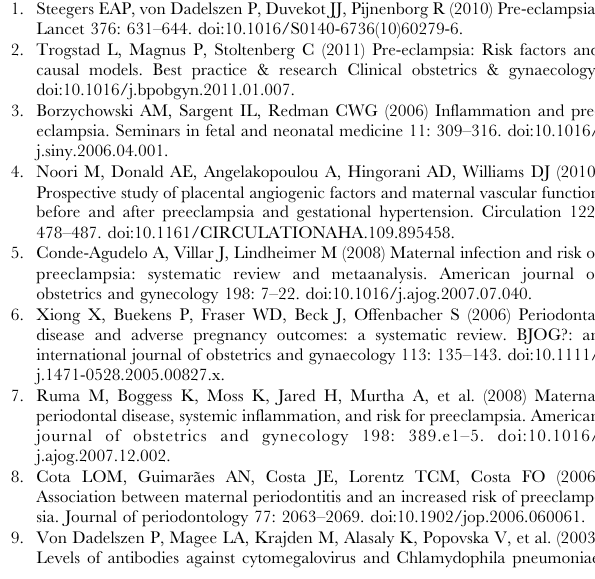
Table S1 The association between maternal infection and pre-eclampsia: crude and adjusted odds ratios for matched cases and controls with data on pre-pregnancy BMI and smoking status in pregnancy (n= 1048 cases;